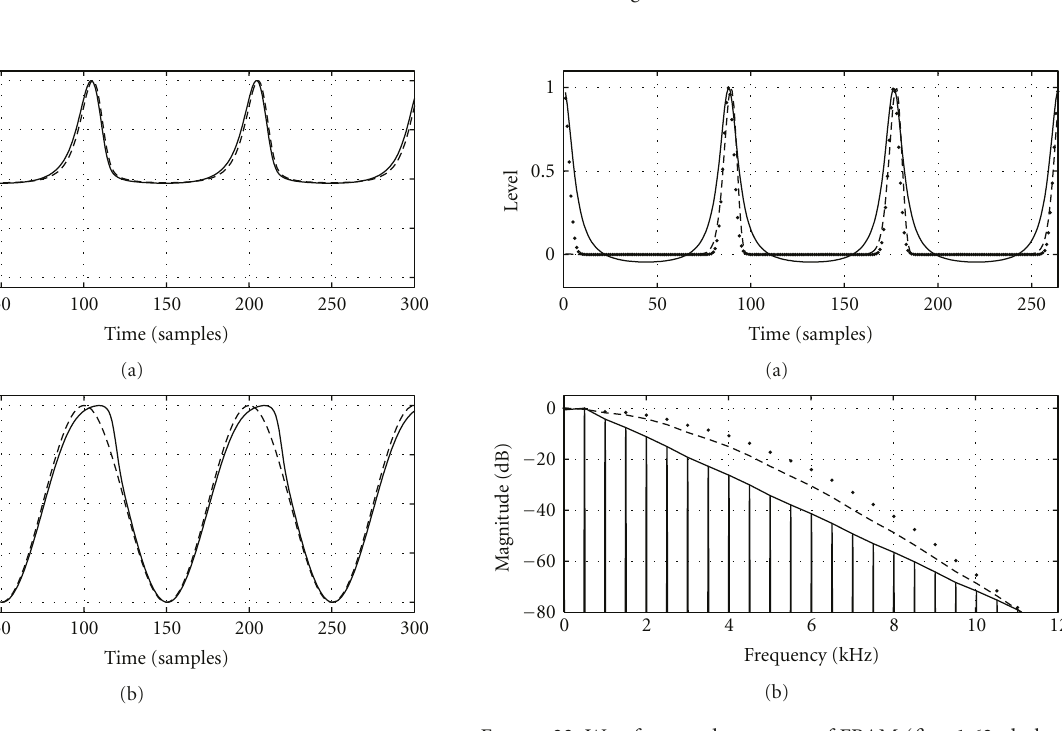
Figure 21: (a) FBAM waveform (dashed) and reconstructed using AM (solid). (b) Cosine waveform (dashed) and FBAM reconstruction using PM (solid). Signals were generated with β = 1 and f 0 = 500Hz.